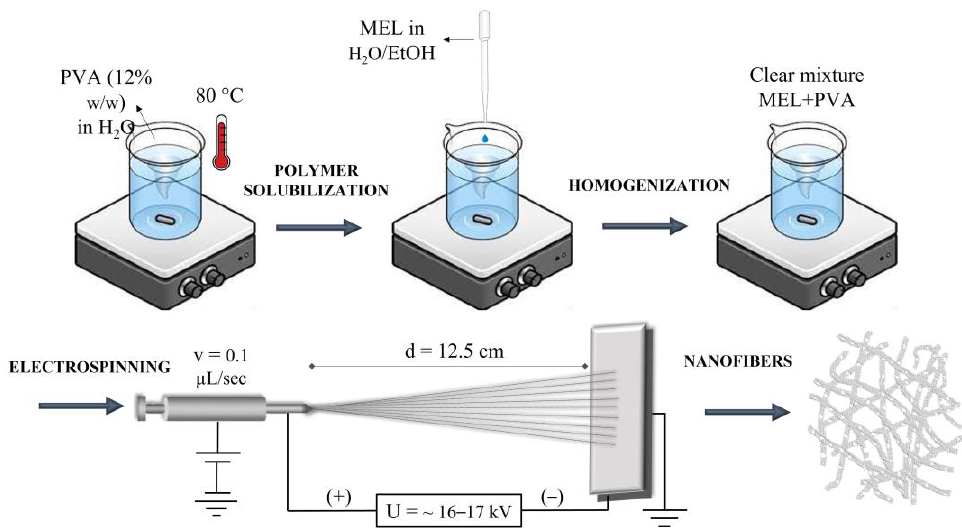
Figure 2. Schematic illustration of the production of melatonin-loaded PVA